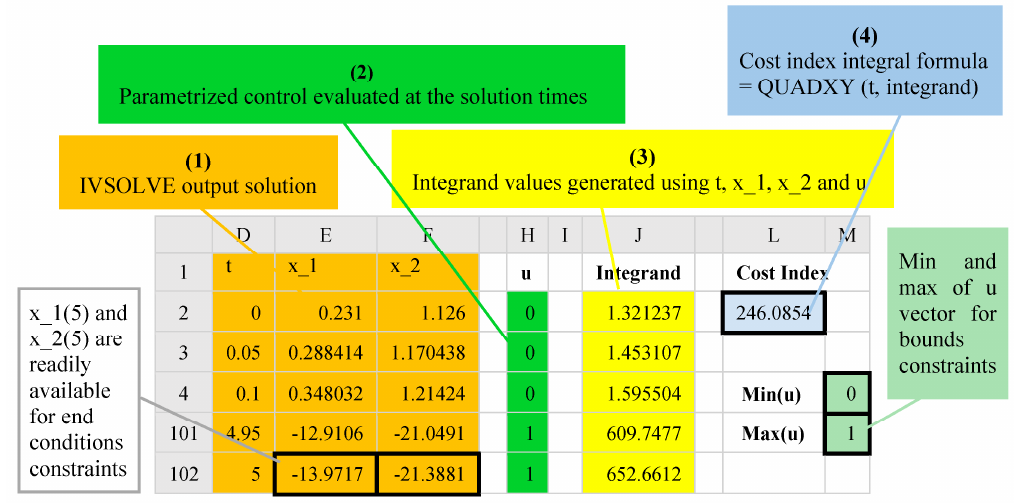
Figure 1. Flowchart for the design of a mathematically pure spreadsheet solver function which accepts formulas as input arguments. Enabling technology is described in [8,9].